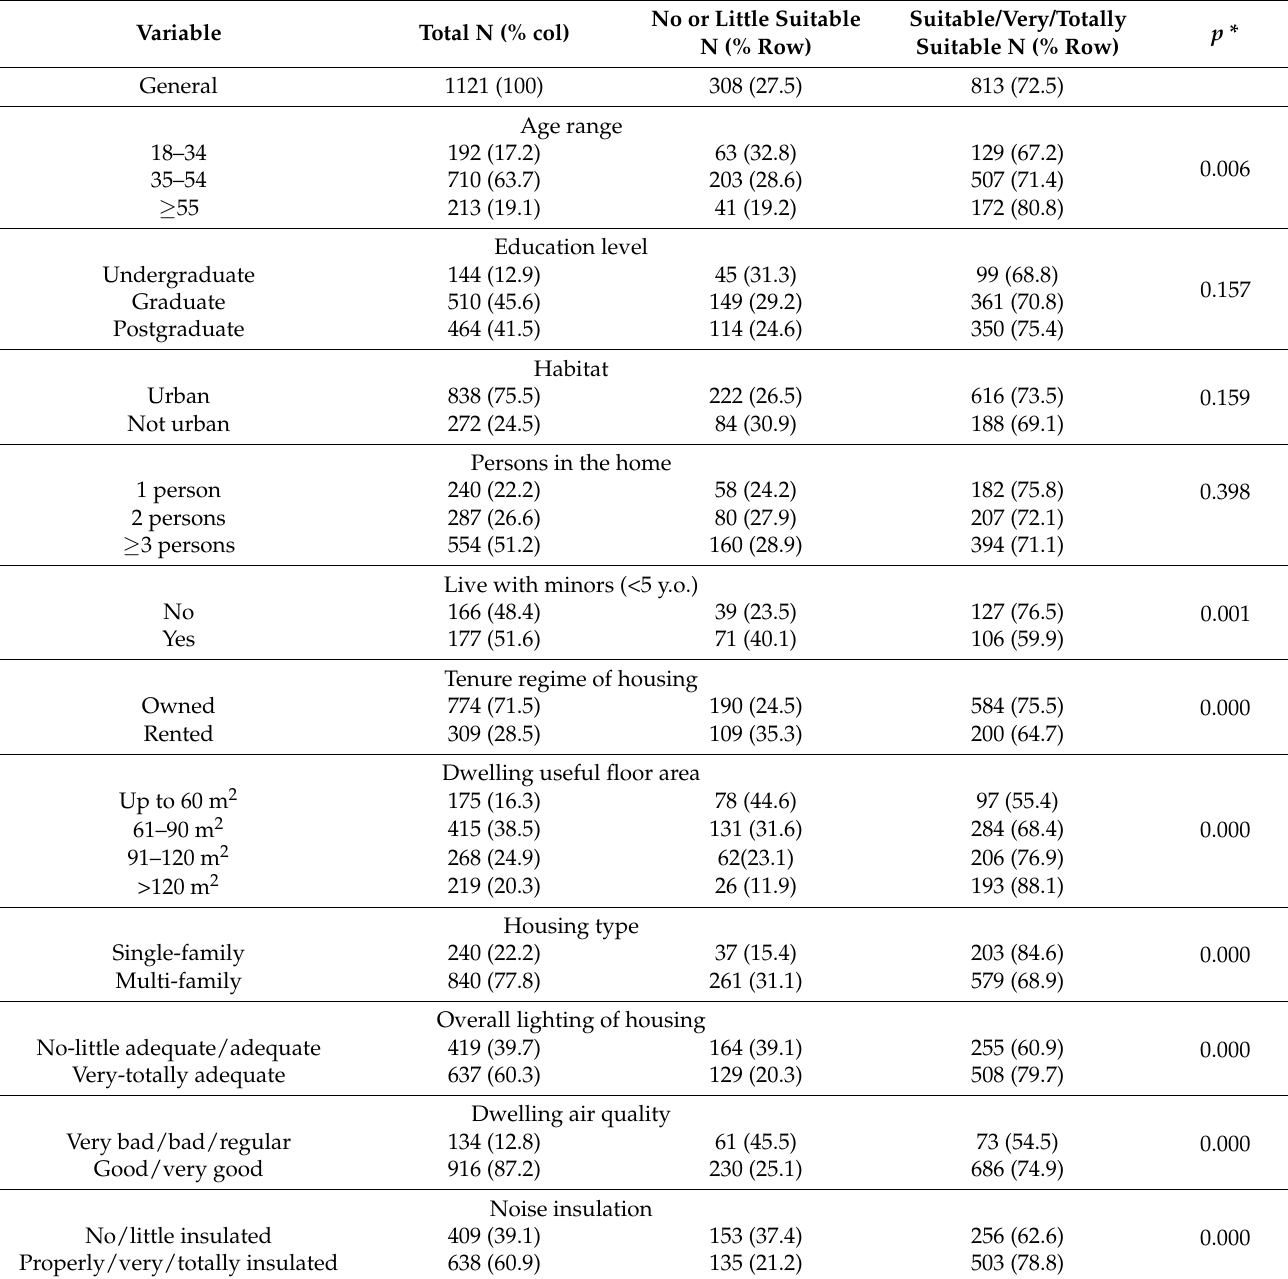
Table 2. Characteristics of households and dwellings and the adequacy of the teleworking